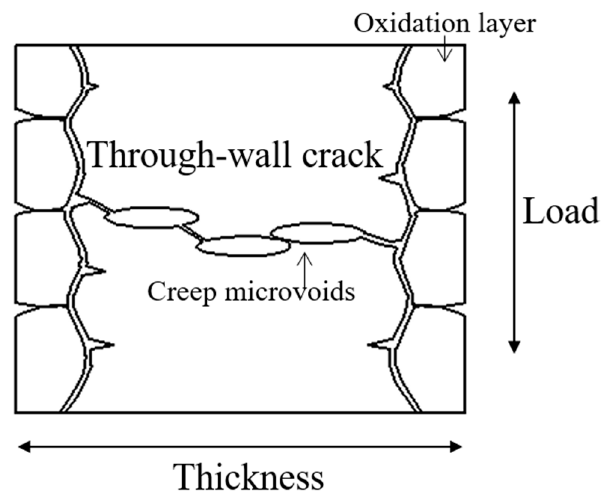
Figure 17. Creep damage mechanism and through-wall crack formation